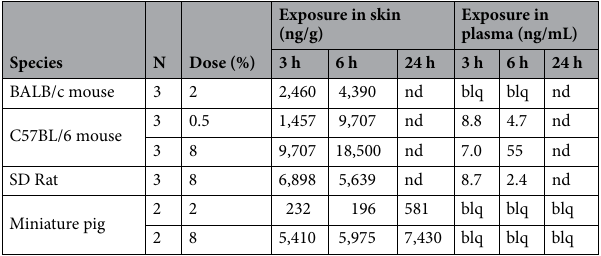
Table 2. Exposures of SHR168442 in Vaseline via topical route in skin and plasma of mice, rats, and miniature pigs. nd not determined, blq below limit of quantitation (< 6